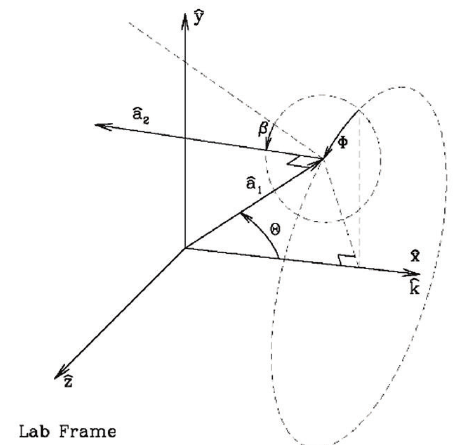
Figure 6. Target orientation in the laboratory frame coordinate system